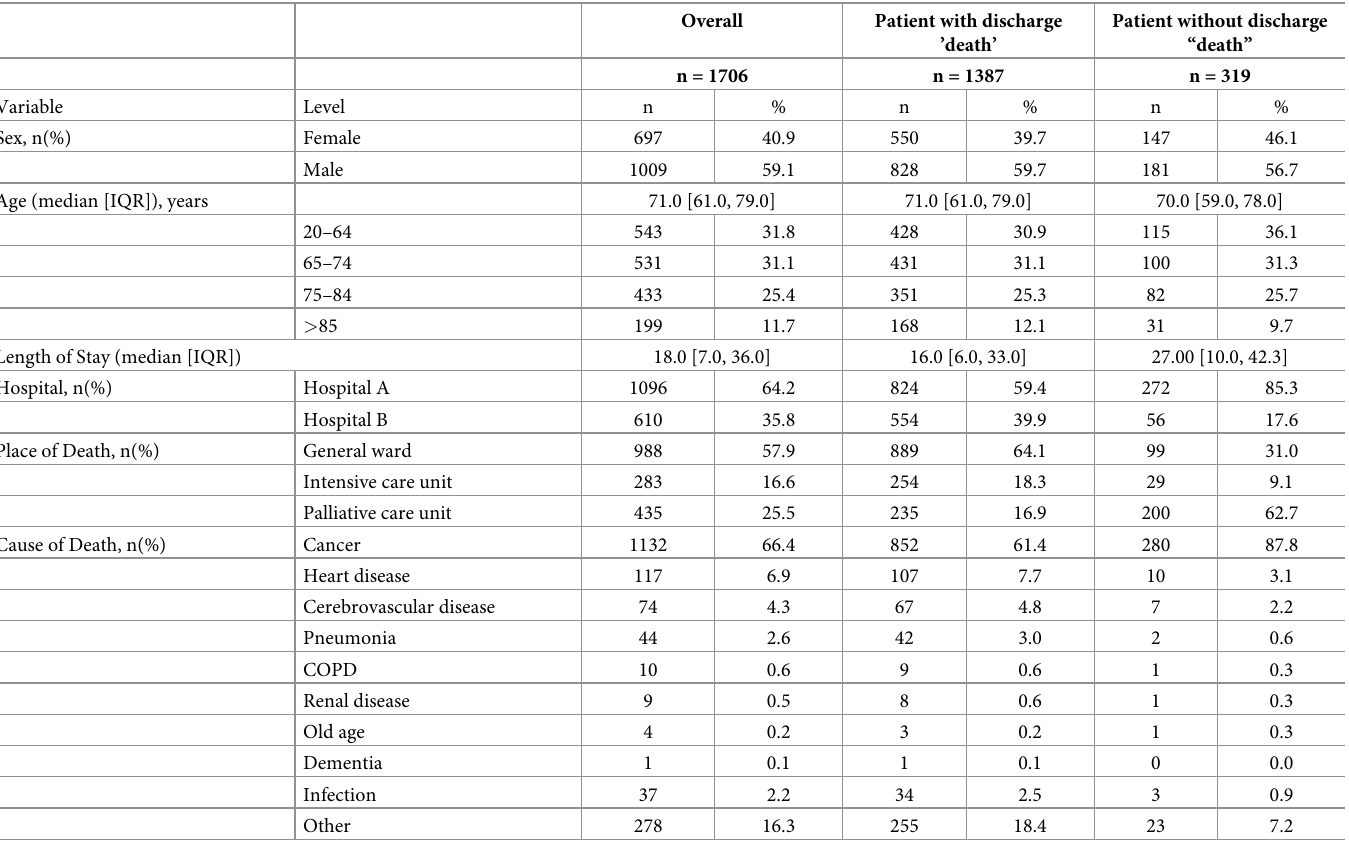
Table 2. Characteristics of patients who fulfilled the eligibility